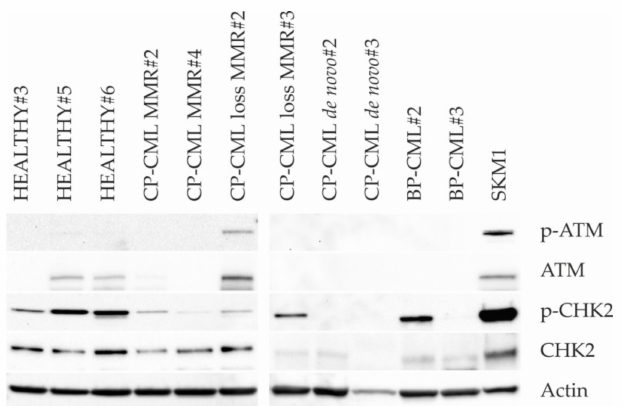
Figure 3. DNA damage response (DDR) in PBMCs of healthy donors and CML patients. Representative Western blots of (p-)ATM and (p-)CHK2 in PBMC of three healthy donors (HEALTHY#3, HEALTHY#5, AND HEALTHY#6), two CP-CML patients in MMR (CP-CML MMR#2 and CP-CML MMR#4), two CP-CML patients with loss of MMR (CP-CML loss MMR#2 and CP-CML loss MMR#3), two de novo untreated CP-CML patients (CP-CML de novo#2 and CP-CML de novo#3), and two BP-CML patients (BP-CML#2 and BP-CML#3). In PBMCs of healthy donors, CP-CML patients in MMR, and CP-CML patients with loss of MMR, no or minor expression of p-ATM and variable expression of p-CHK2 were evident. Notably, in PBMCs of de novo CP-CML patients and BP-CML patients, no expression of p-ATM and predominantly no expression of p-CHK2 were observed (except for strong expression of p-CHK2 in BP-CML#2). SKM-1 acute myeloid leukemia cells served as positive